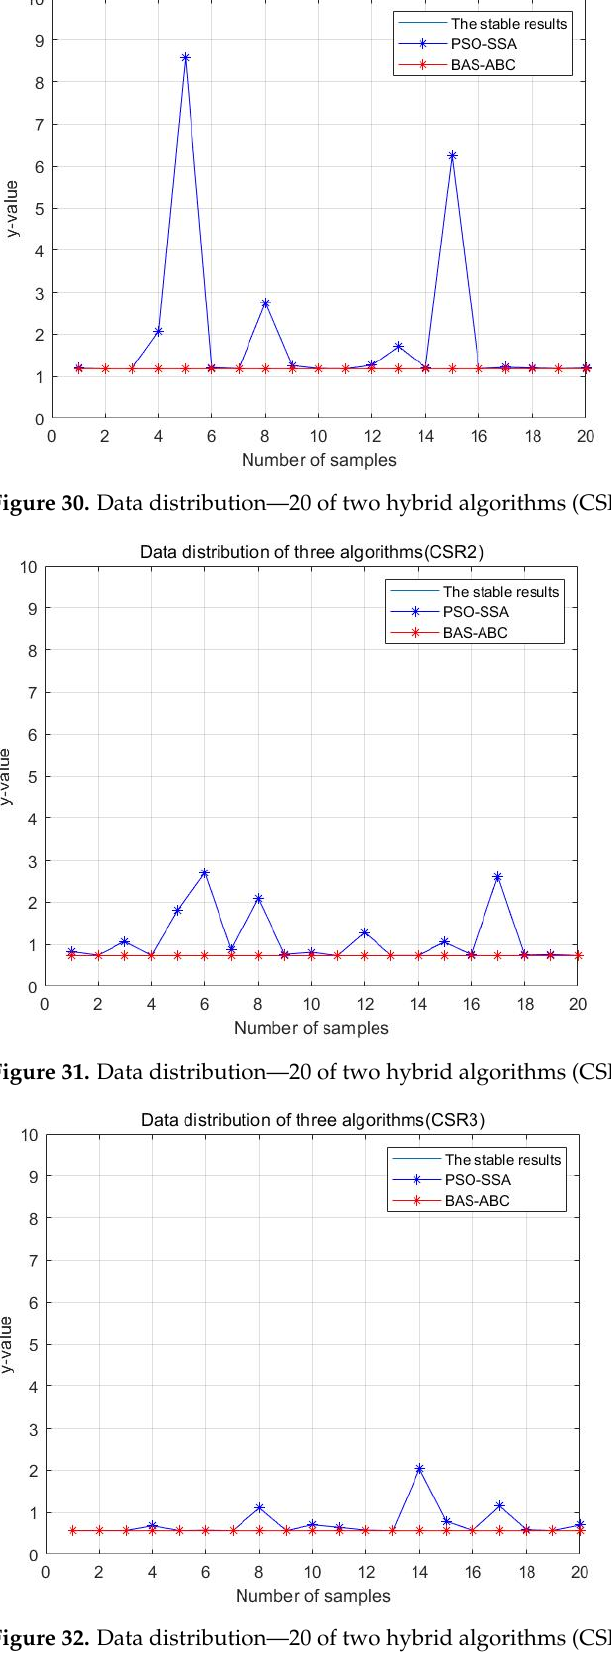
Figure 32. Data distribution—20 of two hybrid algorithms (CSR3).